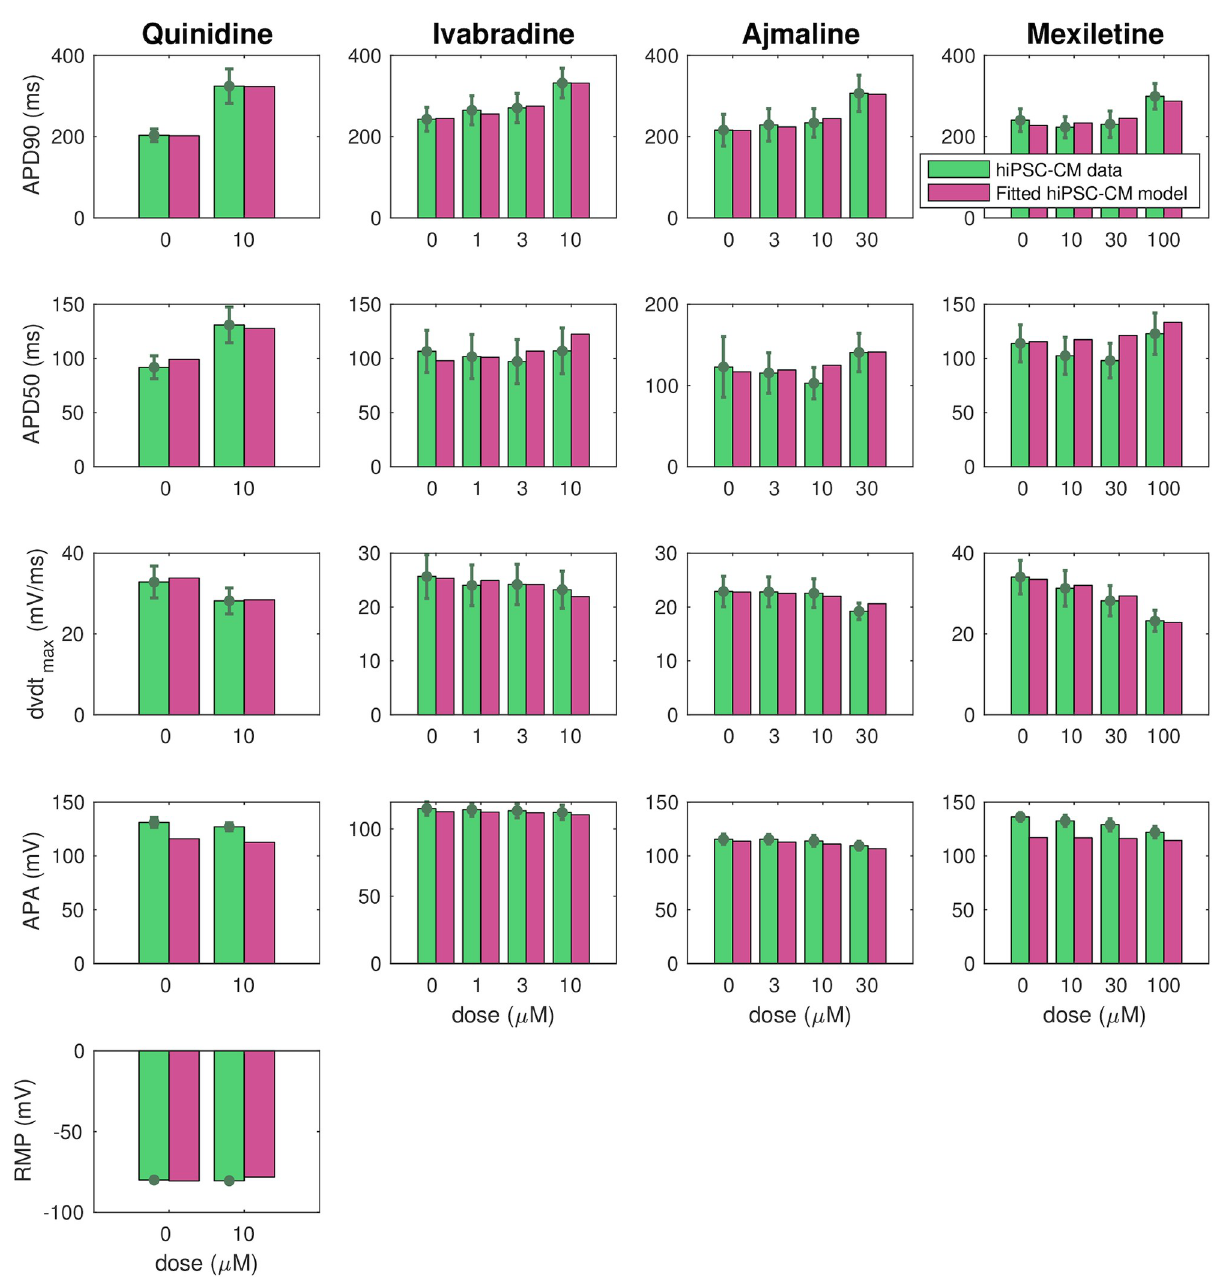
Fig 7. Comparison of measured and computed action potential biomarkers. We consider the biomarkers reported in the data from [9, 11] (green) and computed from the fitted SQT1 hiPSC-CM models returned by the inversion procedure described in Section 2.3 (purple) for the drugs quinidine, ivabradine, ajmaline and mexiletine. Note that the definition of each of the biomarkers are illustrated in Fig 3 and that RMP data are only included for the quinidine case. Data are shown as the mean ± SEM (standard error of the mean). Data used in this figure can be found in S1